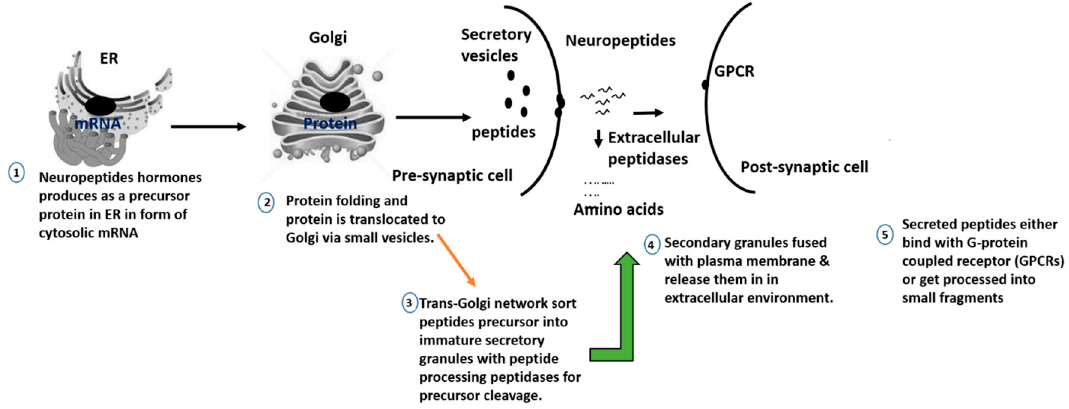
Figure 4. An overview of neuropeptide biosynthesis.